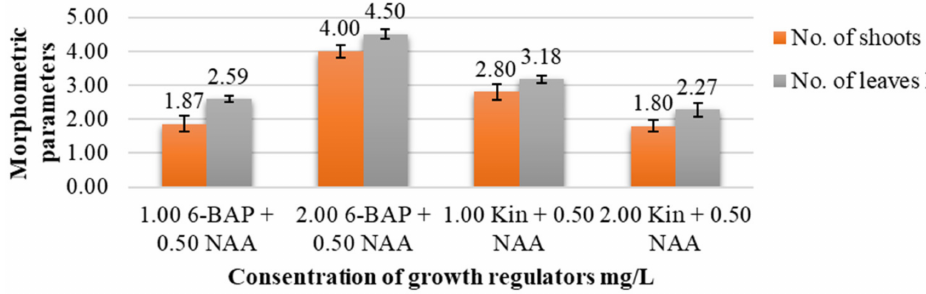
Figure 5. Effect of different growth regulators on shoot and leaf number of C. erythrostylum plantlets at 120 days of in vitro growth (LSD 05 for number of shoots = 0.99; LSD 05 for number of leaves =